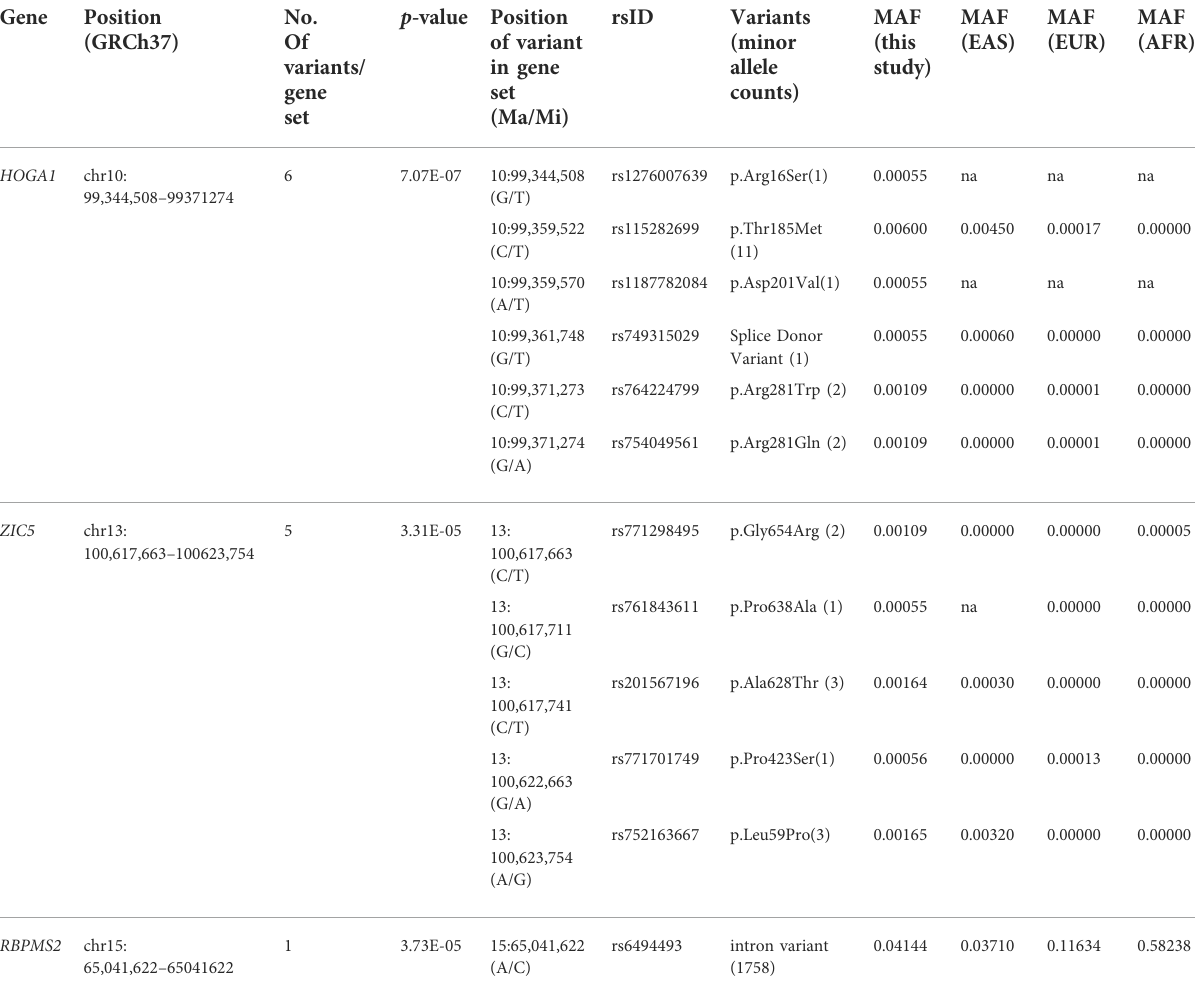
TABLE 1 Top three genes associated with BMI identi fi ed by gene-based test ( p -value < 5 × 10 – 5 ). Gene Position